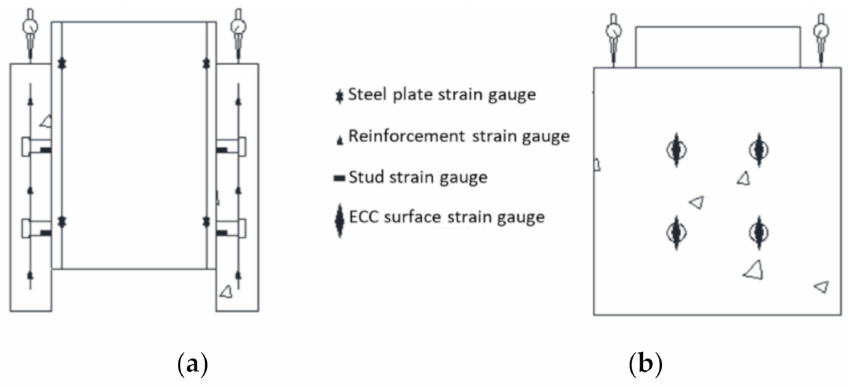
Figure 3. Schematic diagram of displacement gauge and strain gauge location: ( a ) Elevation view; ( b ) Side view.